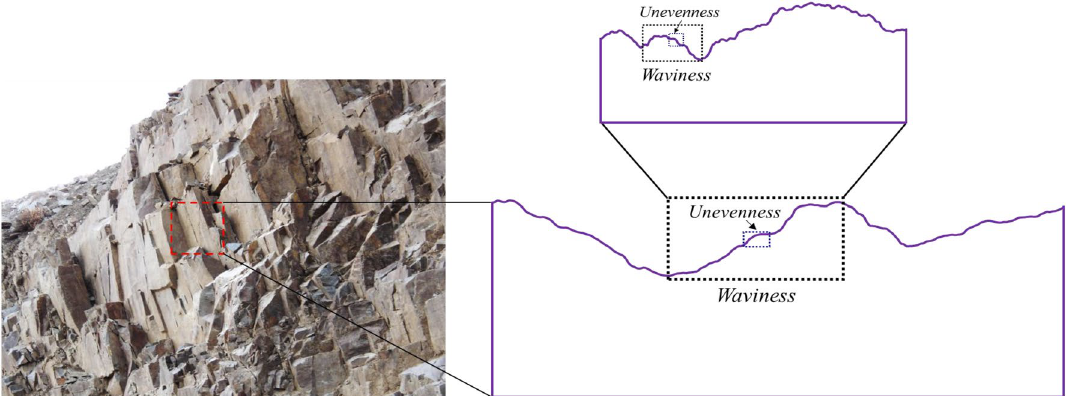
Figure 1. Rock joint surfaces exhibit waviness and unevenness at different scales.